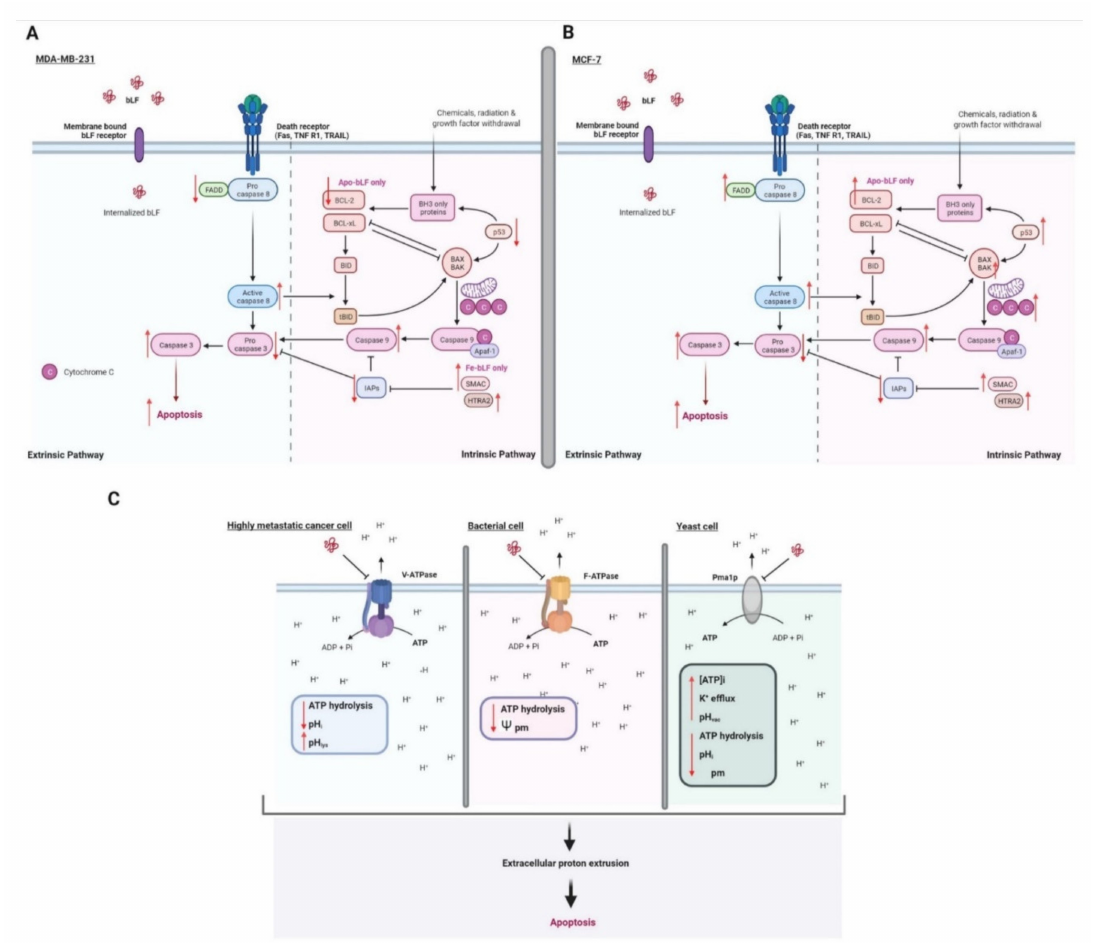
Figure 6. Overview of the mechanism underlying the apoptotic activity of bLF including activation of Fas signaling pathway in MDA-MB-231 cells ( A ), mitochondrial-related pathway in MCF-7 cells ( B ) and inhibition of plasmalemmal V-H+-ATPase proton pumping of highly metastatic cancer cells (V-ATPase), bacteria (F-ATPase) as well as yeast (Pma1p). ( A , B ) The internalized, Apo-bLF and Fe-bLF via membrane bound LF receptors in the process of endocytosis, induce or/and inhibit key apoptotic proteins. ( C ) The inhibition of proton efflux trigger extracellular alkalinisation and intracellular acidification. Modulation of key apoptotic molecules level or processes that lead to cell death are indicated by the red arrows. pH i : intracellular pH; pH lys : lysosomal pH; pH vac : vacuolar pH; [ATP] i : intracellular ATP concentration; ψ pm : plasma membrane potential. Illustration was created in BioRender.com (accessed on 21 April 2022) based on